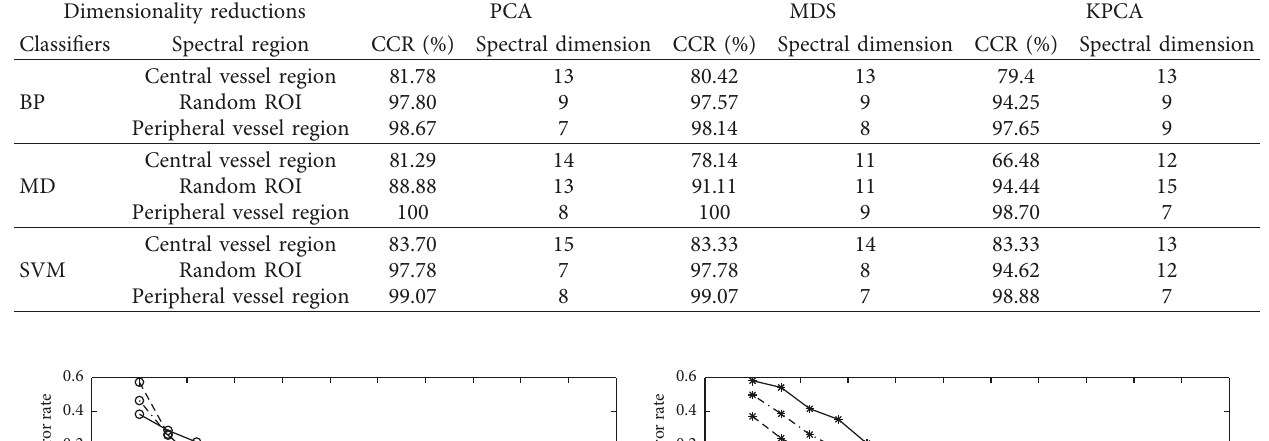
Table 4: Best classification results with different classifiers and spectral dimensionality reductions. Dimensionality reductions